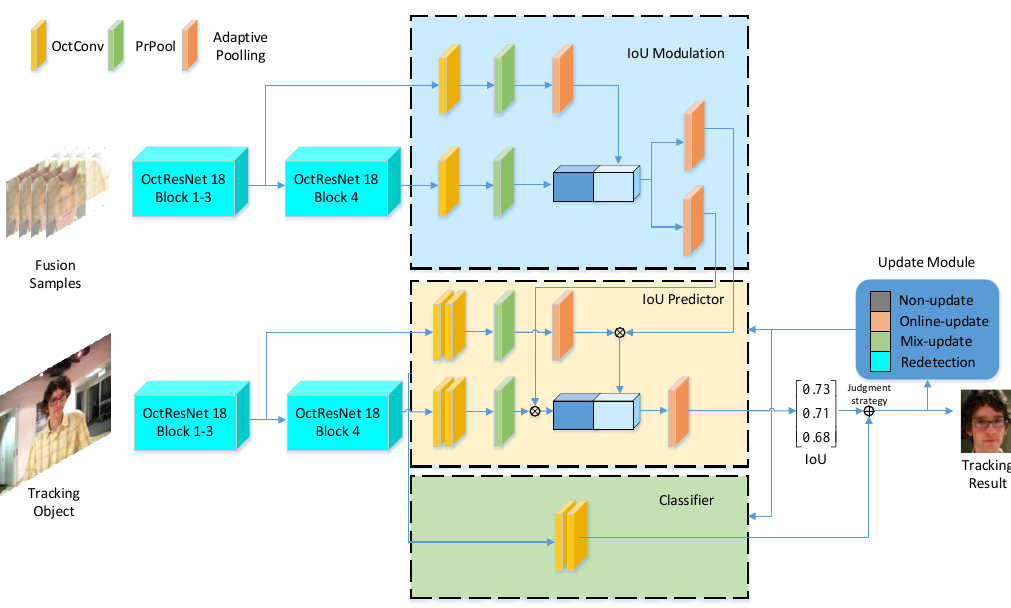
Figure 1. The framework of the proposed frequency-aware feature